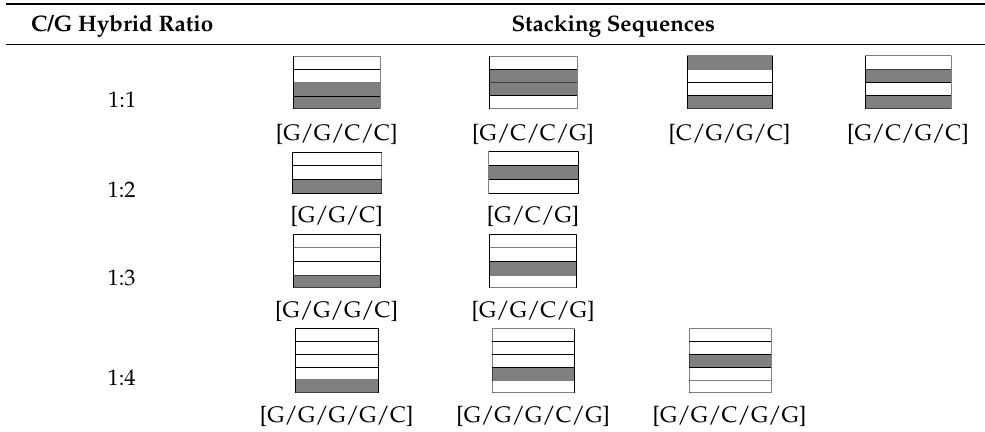
Note: the carbon fabric layer is indicated by black color, while the white color denotes the presence of glass fabric in the laminates.